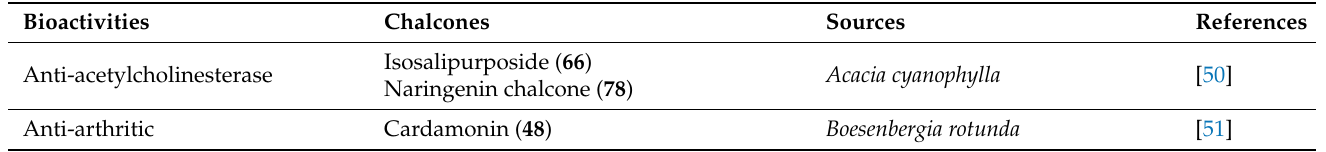
Figure 10. Structures of some naturally occurring bioactive chalcones. Table 2. Bioactivities of some naturally occurring chalcones.